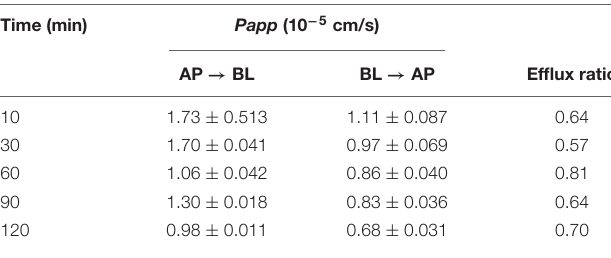
TABLE 4 | The effect of time on transport of PA in the Caco-2 cell monolayer model ( ¯ x ± SD, n = 3). Time